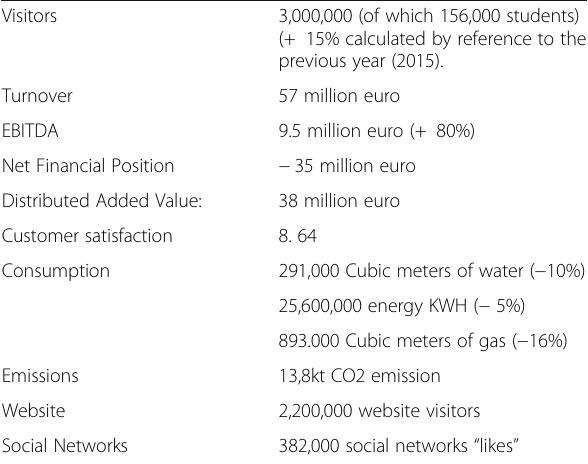
Table 1 Costa Edutainment highlights (2016)